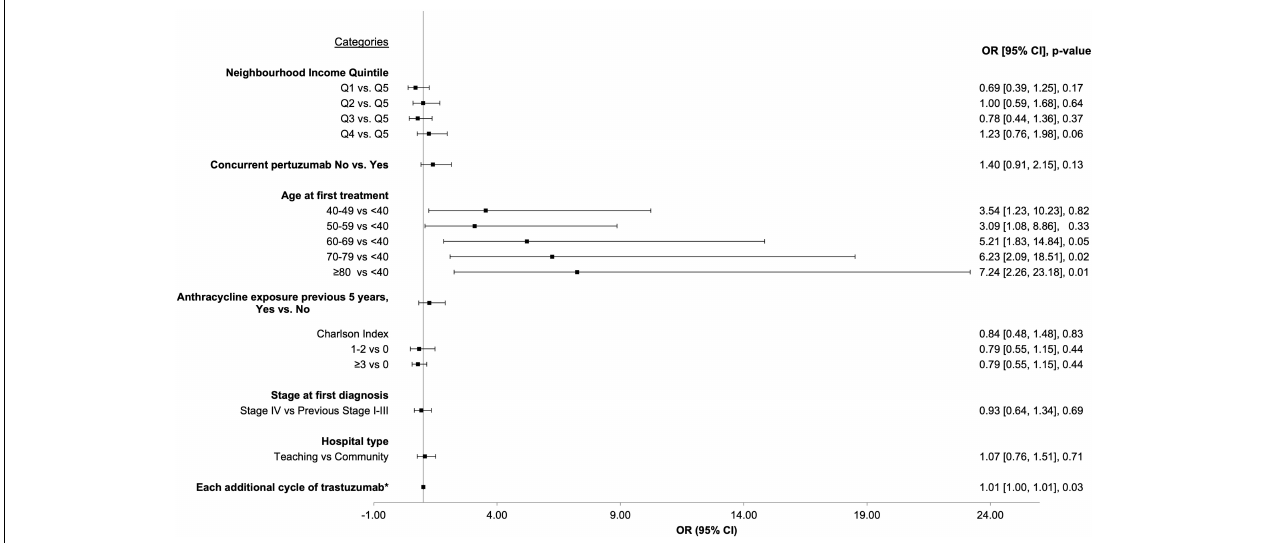
FIGURE 2 | Forrest plot depicting results from logistic regression for factors associated with increased odds of cardiac event.